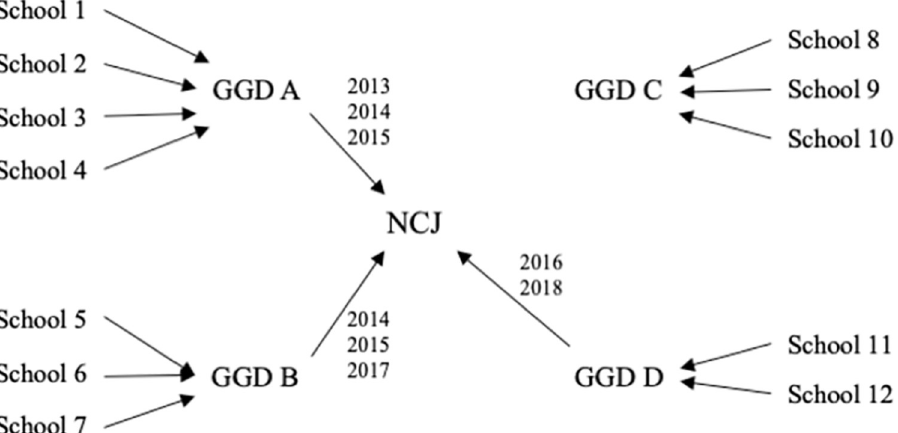
Fig 1. Graphical display of how data were obtained. Visual representation of how the anthropometric data was obtained. GGDs send a nurse to schools to measure examine the health of children in year seven of primary education. Some GGDs have shared their data with NCJ (A, B, D) between 2013–2018, but might not have done so for the entire period, e.g., GGD B shared data of 2014, 2015, and 2017 with